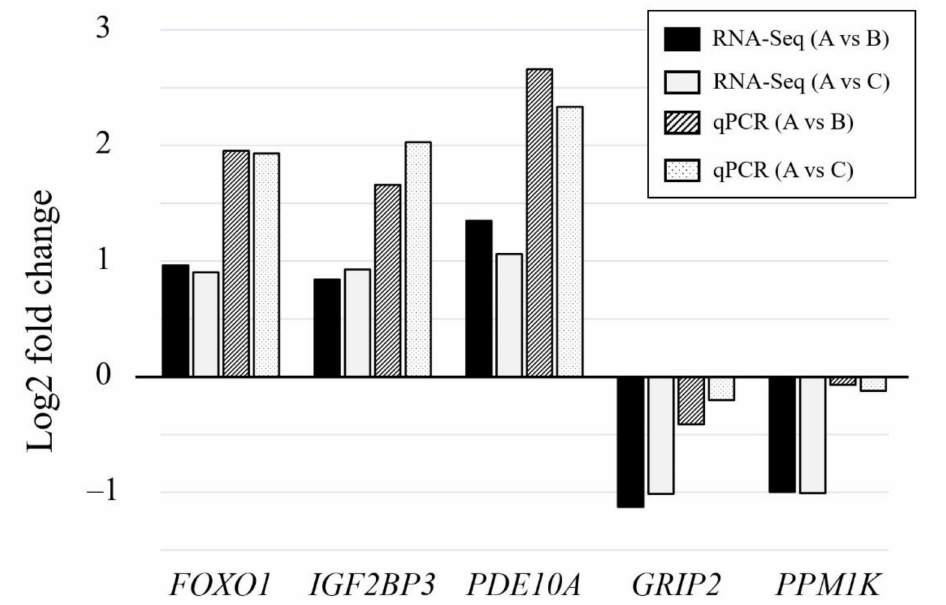
Figure 3. Validation of five DEGs detected from RNA-Seq analysis by qPCR. The x -axis represents the gene name and the y -axis represents the mRNA expression levels expressed in a fold change value. The expression levels obtained by RNA-Seq and qPCR are represented by solid fill and pattern fill columns, respectively. A, B, and C represent the non-supplemented group, the β -alanine supplementation group, and the L-histidine supplementation group, respectively. Gene abbreviation represents forkhead box O1 ( FOXO1 ), insulin-like growth factor 2 mRNA binding protein 3 ( IGF2BP3 ), phosphodiesterase 10A ( PDE10A ), glutamate receptor interacting protein 2 ( GRIP2 ), and protein phosphatase Mg 2+ /Mn 2+ dependent 1K ( PPM1K ),